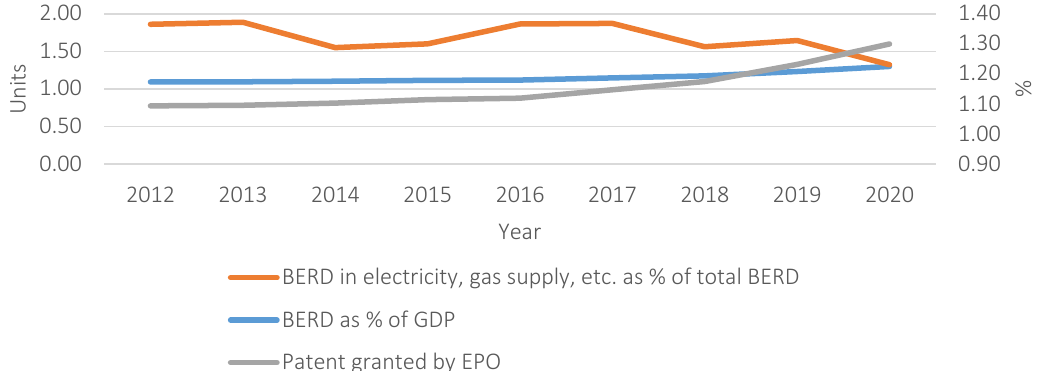
Figure 10. R&D expenditures and patents granted, average for European countries,